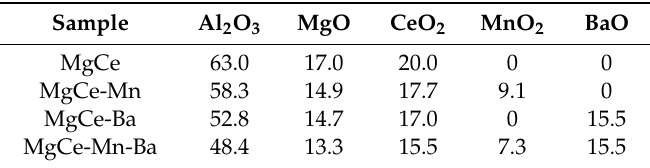
Table 1. Chemical composition (wt%) of the samples determined by Inductively Coupled Plasma (ICP)